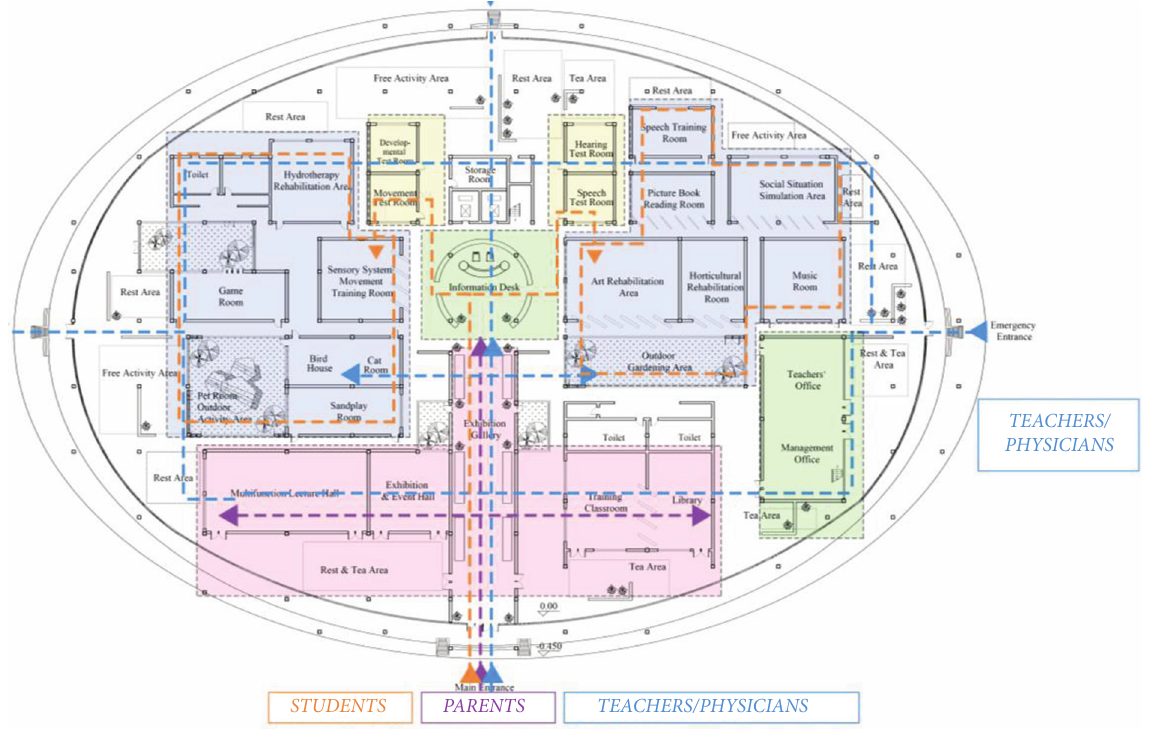
Figure 13: Streamline organization of three kinds.